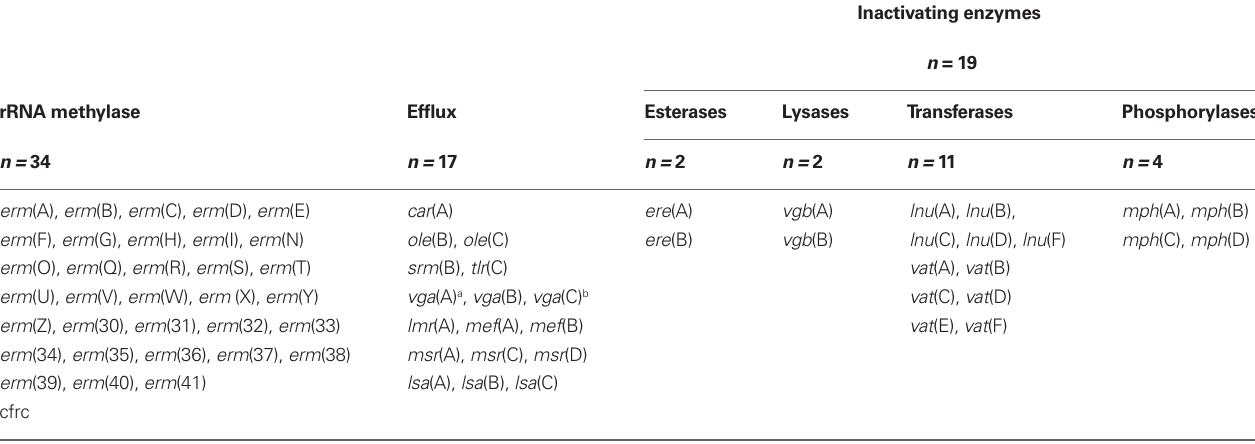
Table 1 | Mechanisms of MLS resistance genes.